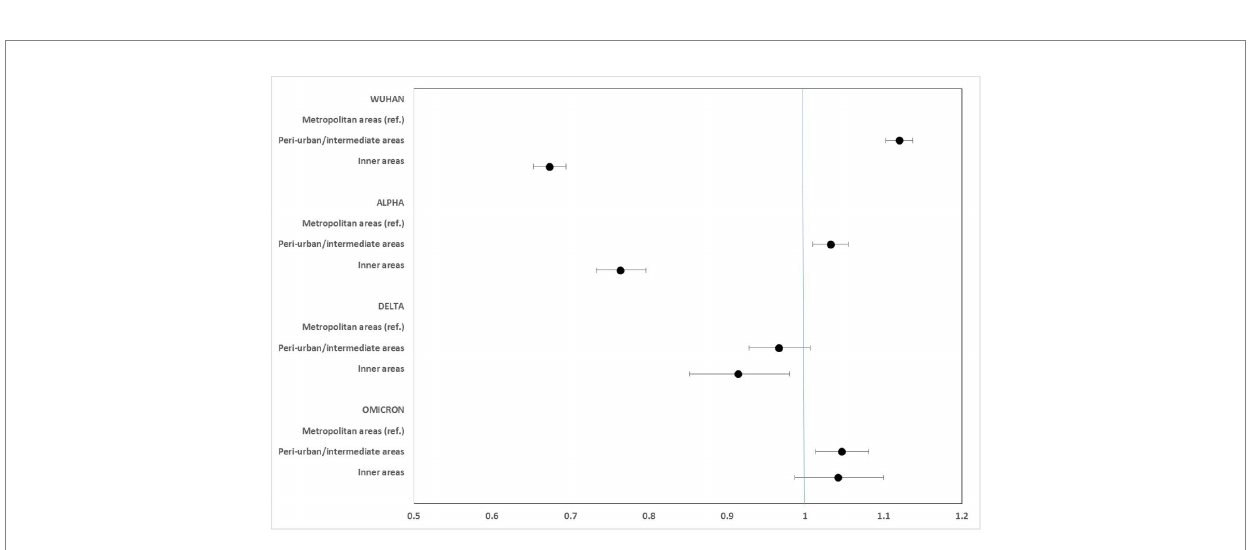
FIGURE 5 Age-adjusted rate ratios with 95%CI of mortality, by study period and class of municipalities. Metropolitan areas as reference